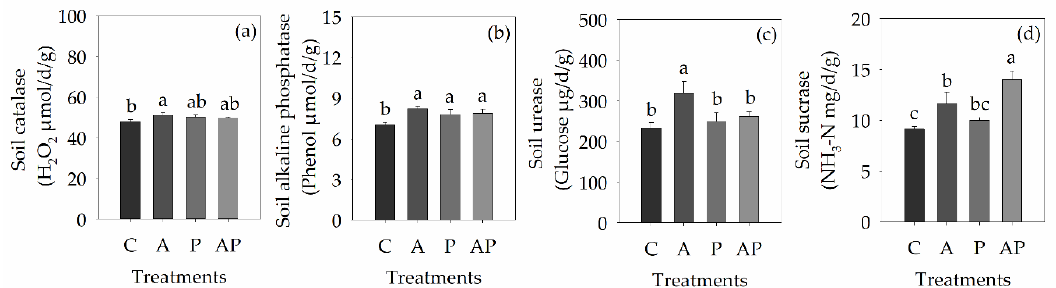
Figure 7. Effects of Glomus mosseae and Bacillus amyloliquefaciens on photosynthetic parameters of Elaeagnus angustifolia L. seedlings in saline soils. Values are the means ± standard deviation of three replicates. Value sharing the different letters indicate significant differences between treatments at the 5% level (Tukey’s t -test). C: Control, A: AMF ( Glomus mosseae ) treatment, P: PGPR ( Bacillus amyloliquefaciens ) treatment, AP: AMF + PGPR treatment. ( a ) soil catalase, ( b ) soil alkaline phosphatase, ( c ) soil urease, ( d ) soil sucrase.